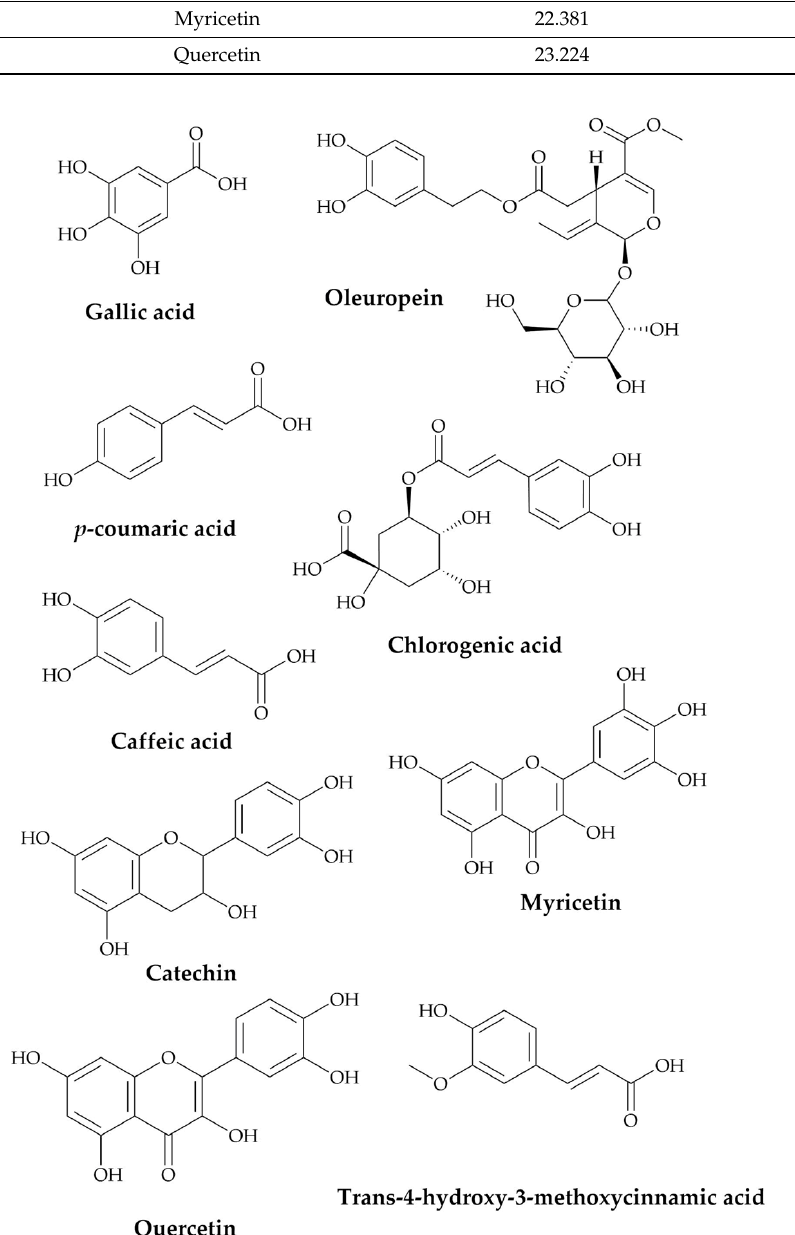
Figure 1. Chemical structures of PATE principle bioactive